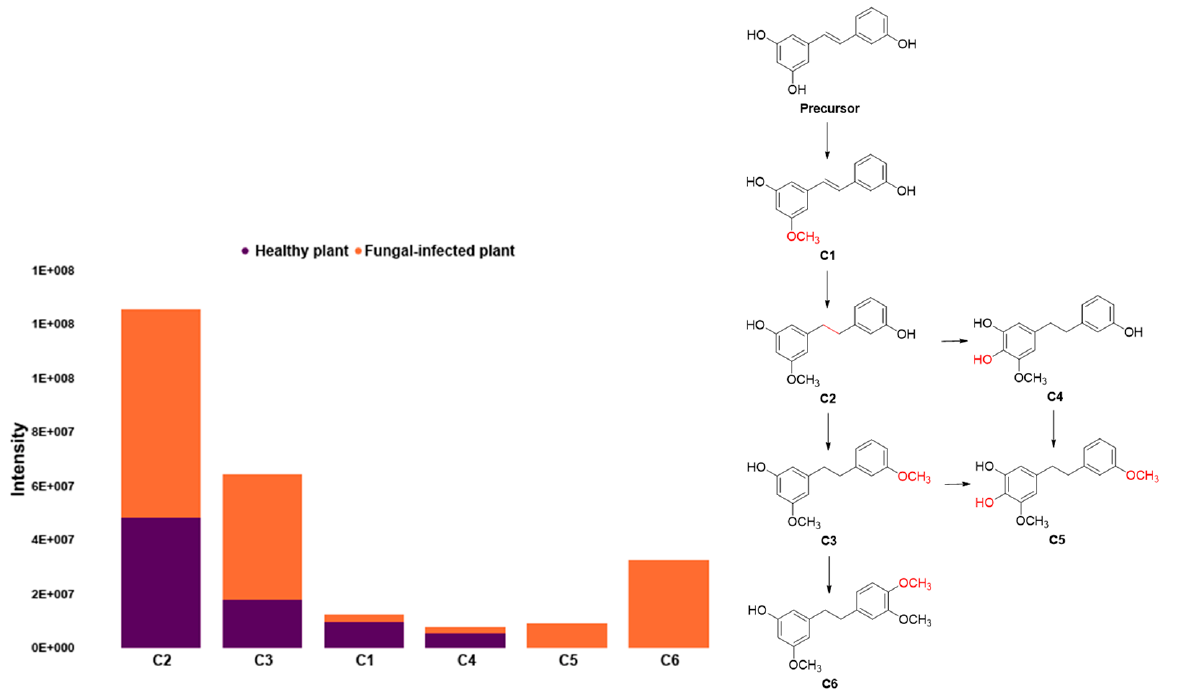
Figure 4. Variation of the metabolic dynamic of stilbenoids in fungal-infected plants (orange) and healthy (violet) plants.